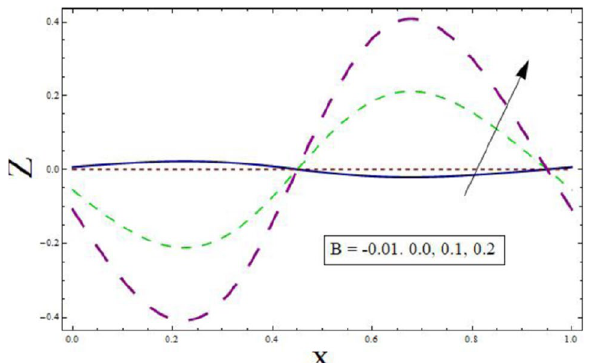
Figure 14. Heat transfer presentation B .